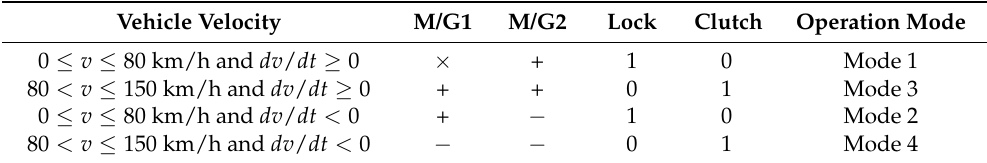
Table 4. Control strategy.